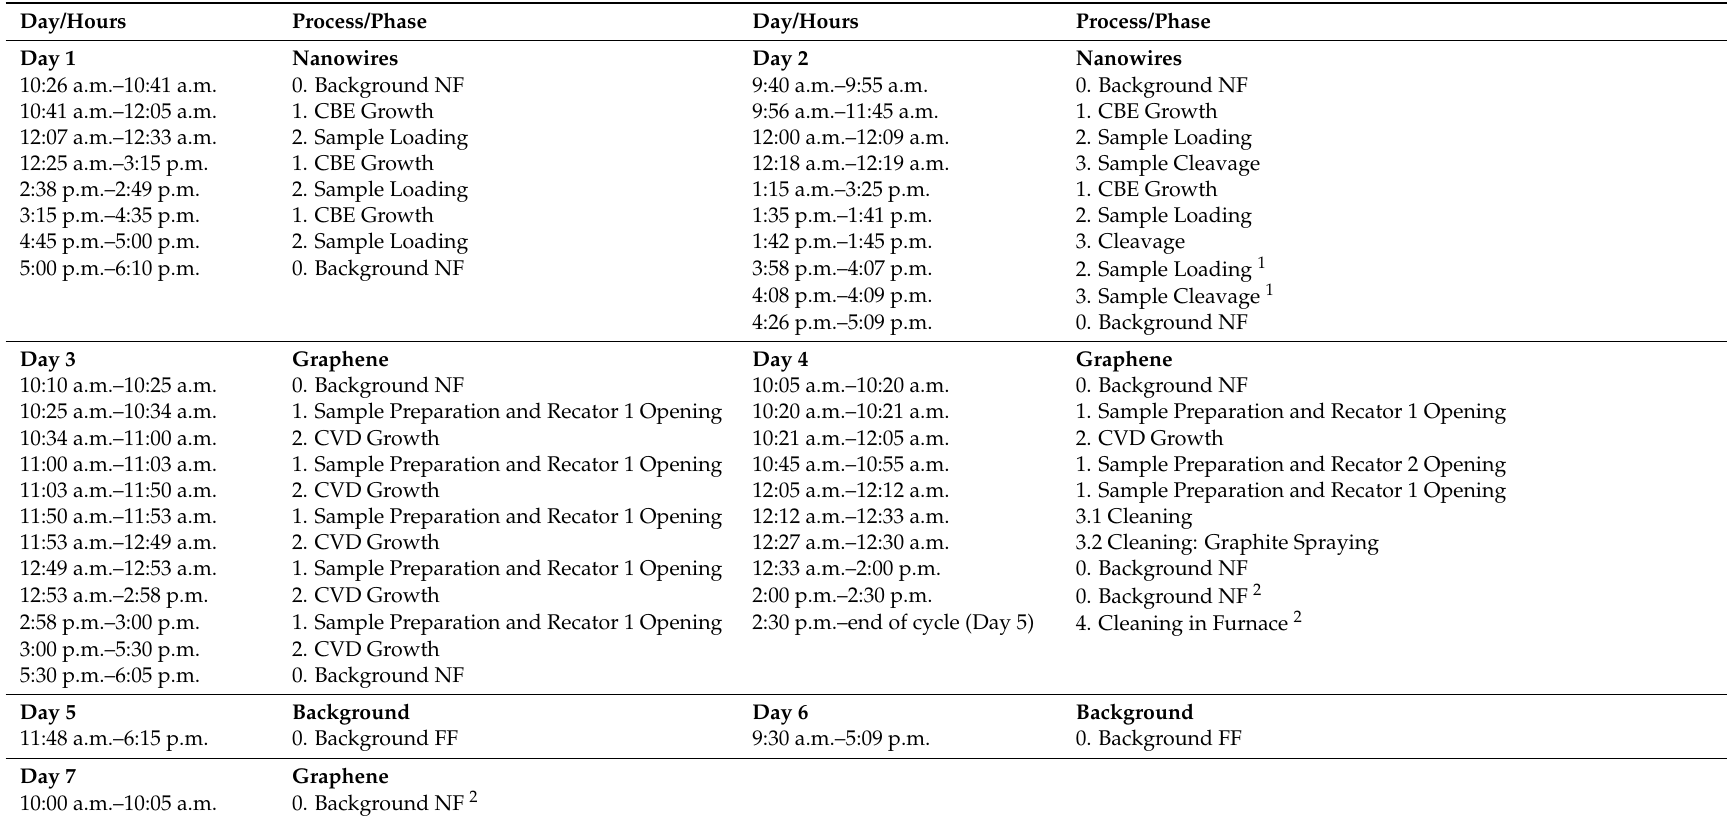
Table 3. Time sheet of measurements during the three case